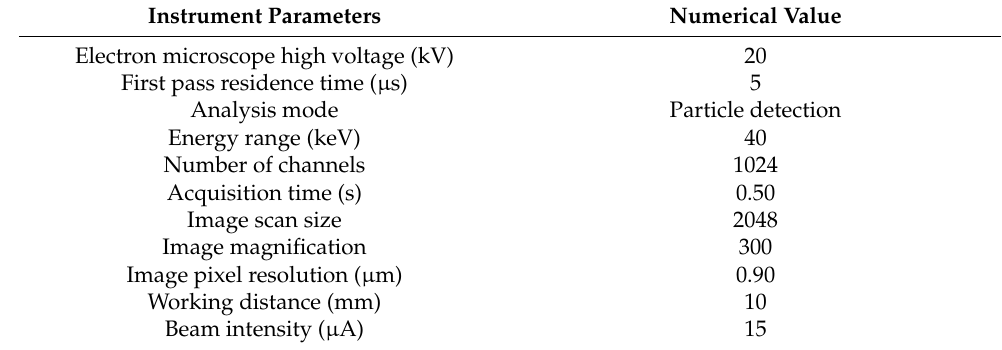
Table 2. Instrument parameters.